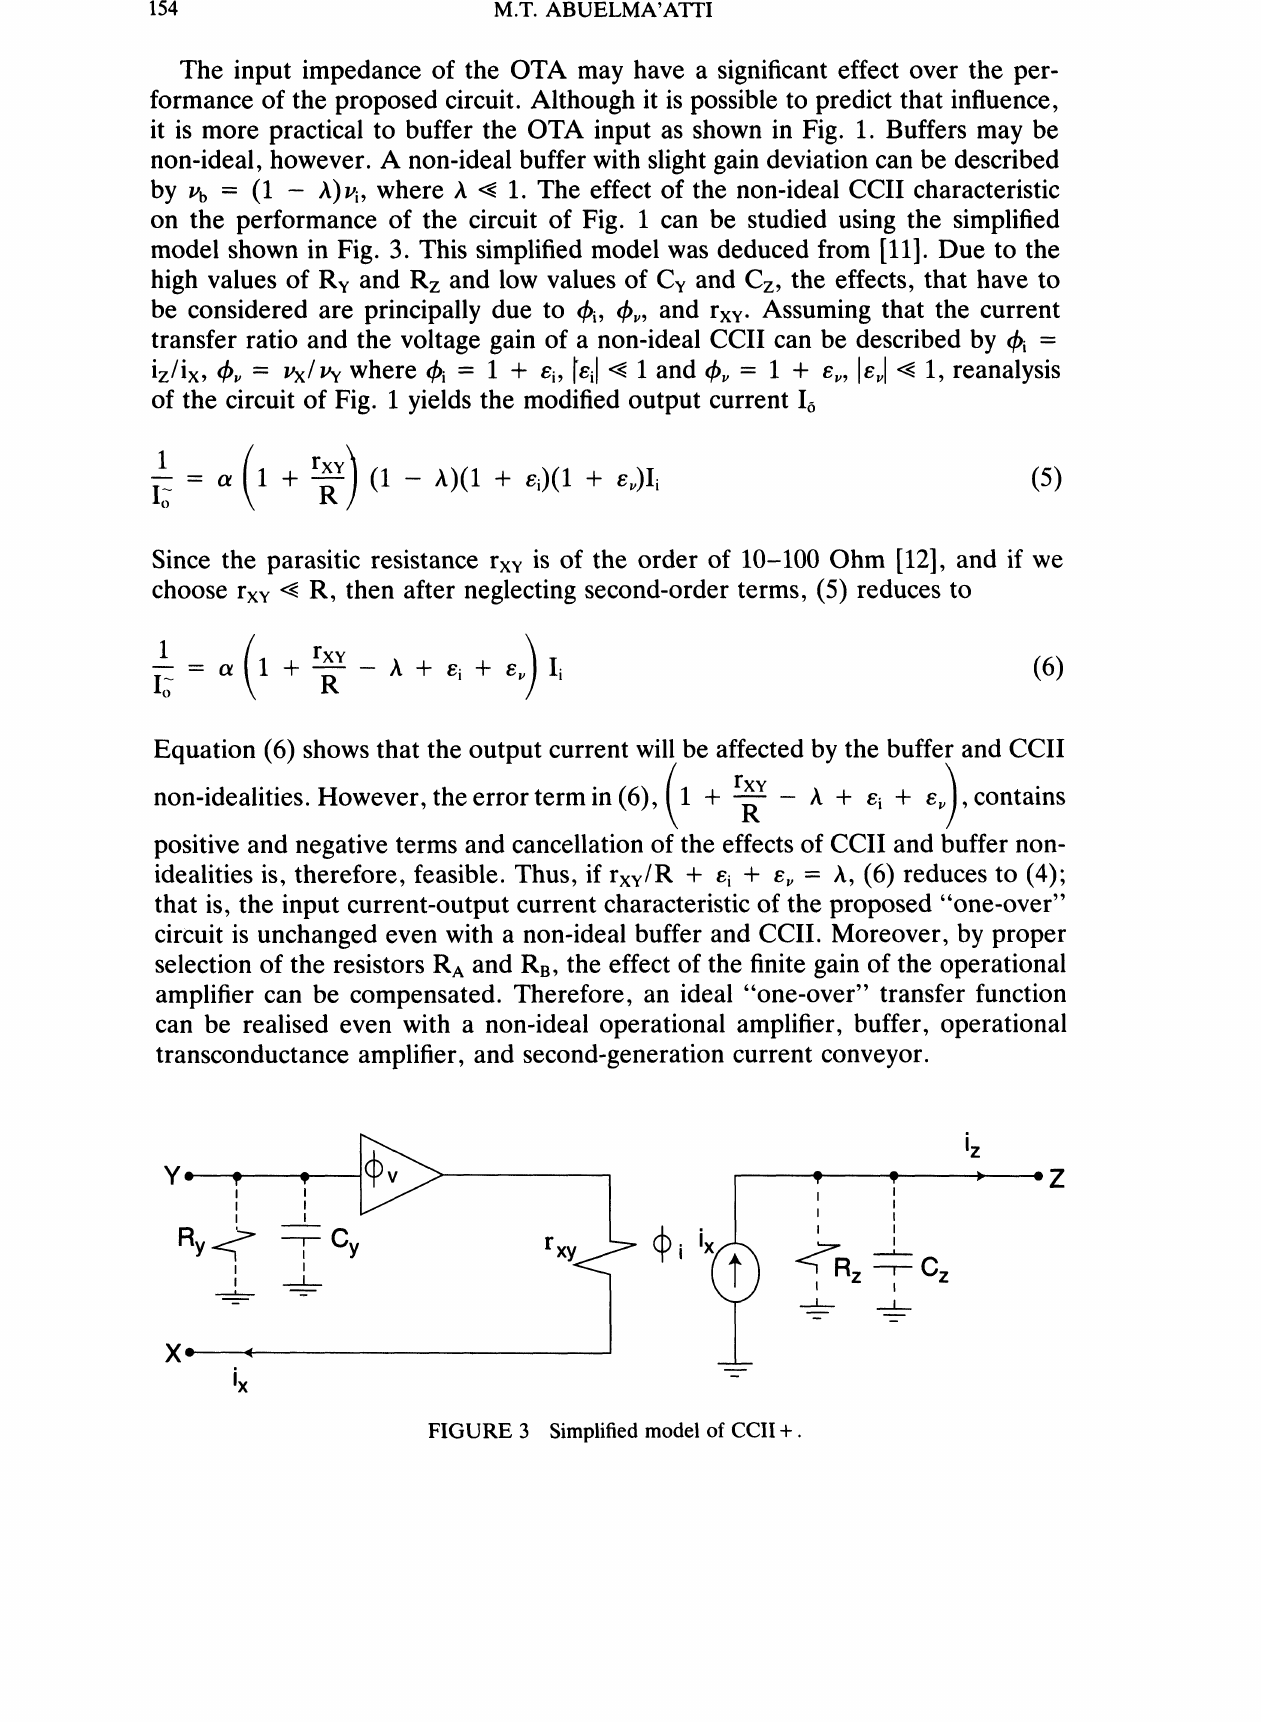
FIGURE 3 Simplified model of